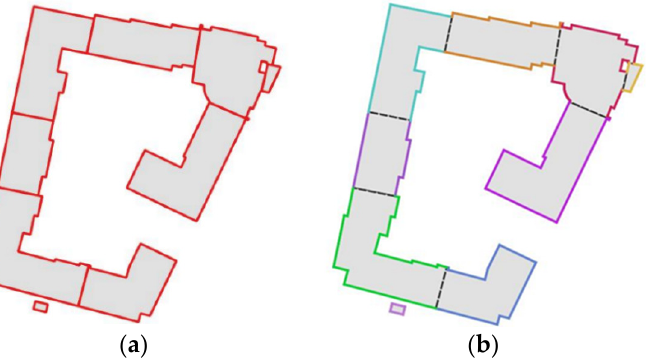
Figure 4. ( a ) The TIC surrounds every building and ( b ) inner TICs (black dashed lines) on adjacent walls are omitted.